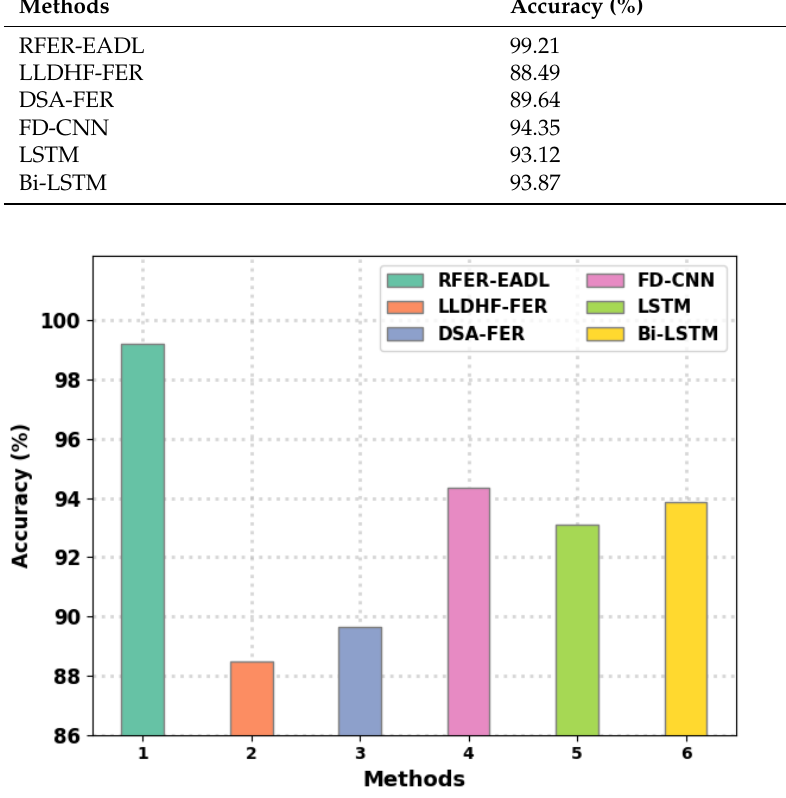
Figure 14. 𝐴𝑐𝑐𝑢 𝑦 analysis of the RFER-EADL approach and other modern